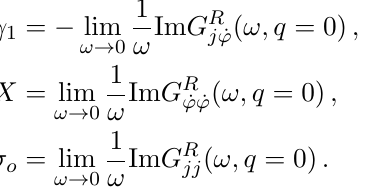
Figure 2 . At all temperatures, the entropy bound (cid:13) 2 bound is